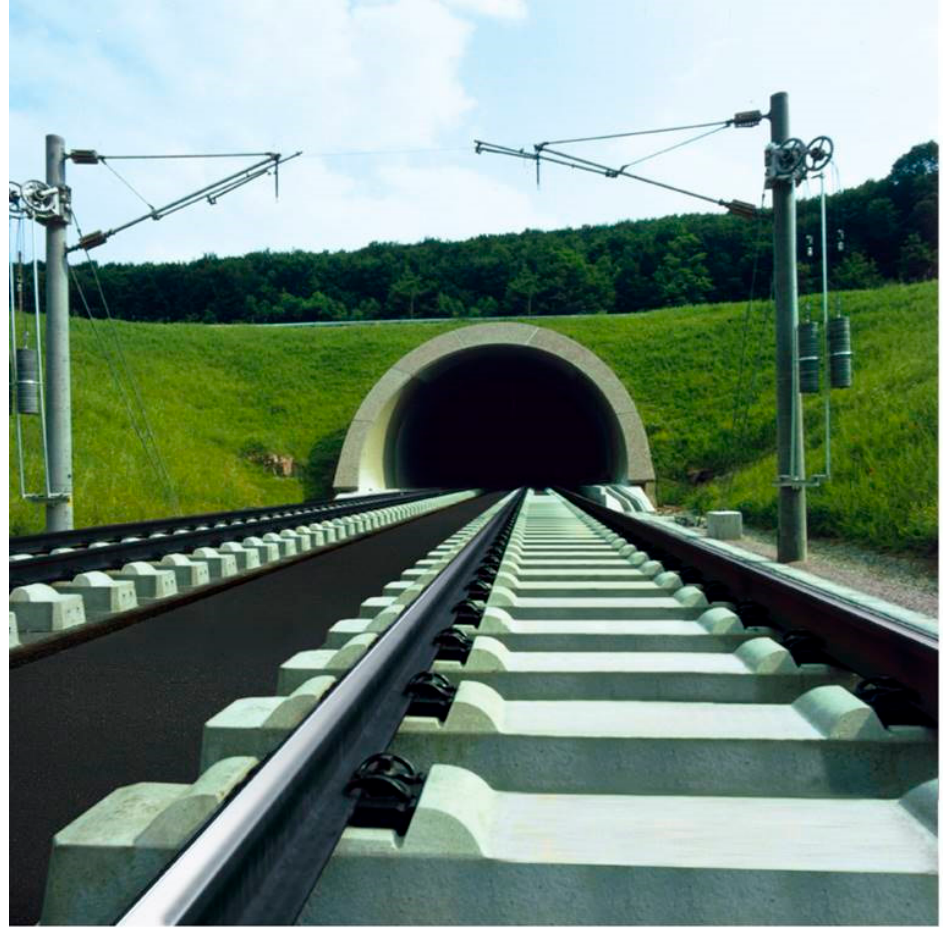
Figure 3. Getrac ballastless system with an asphalt layer (with permission from RAIL.ONE) [27].